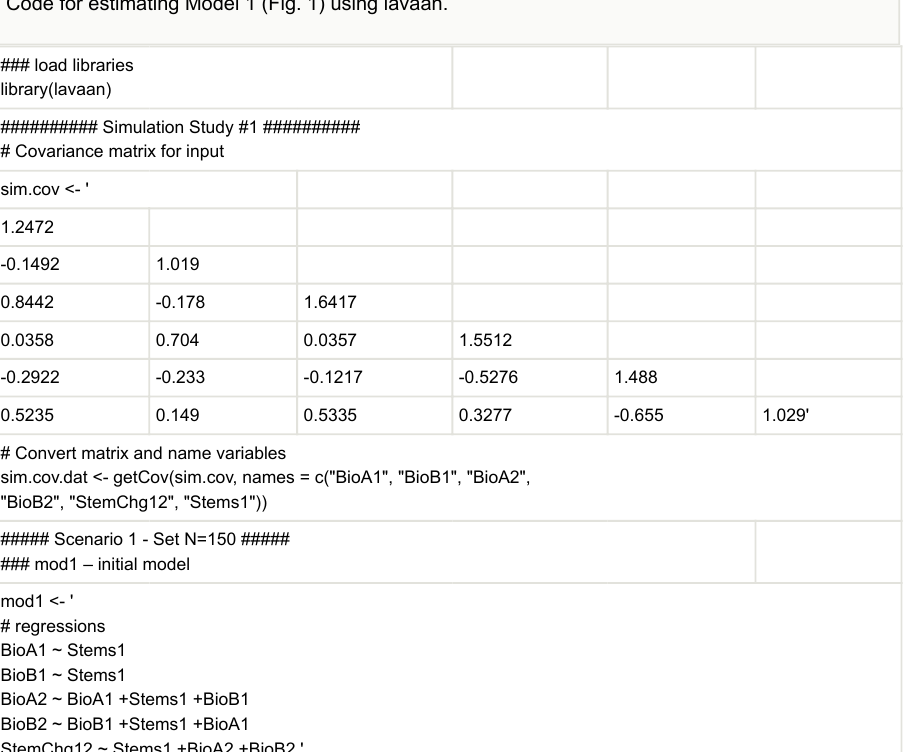
Code for estimating Model 1 (Fig. 1) using